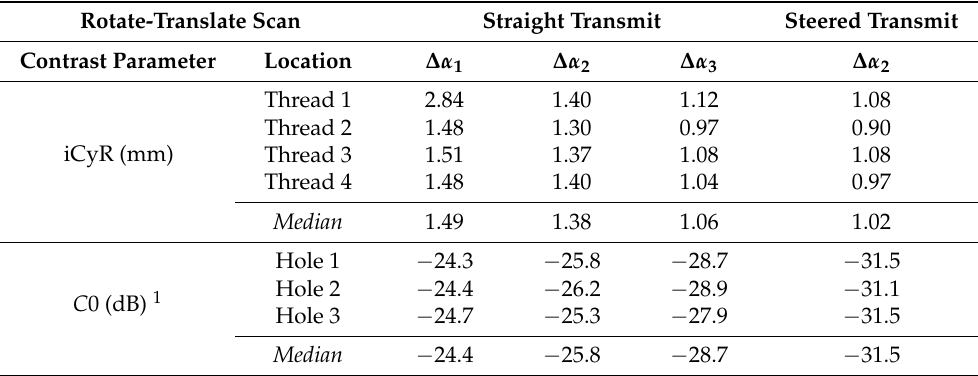
Table 3. Contrast parameters of the different acquisition modes. Translation range of L = 30